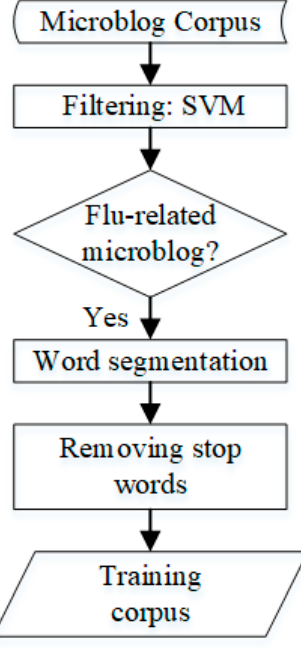
Figure 6. Cleaning Figure 6. Cleaning Data.